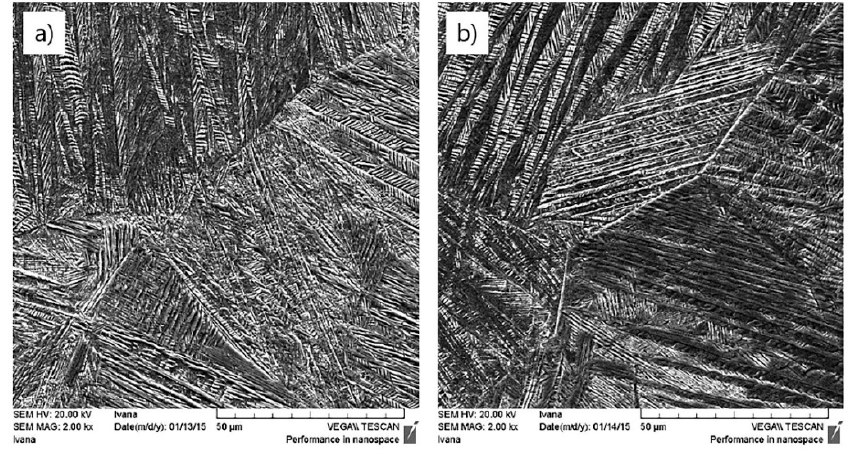
Figure 2. SEM micrographs of CuAlNi shape memory alloy in the as-cast state ( a ) and after solution annealing at 885 °C/60 min H 2 O ( b ).